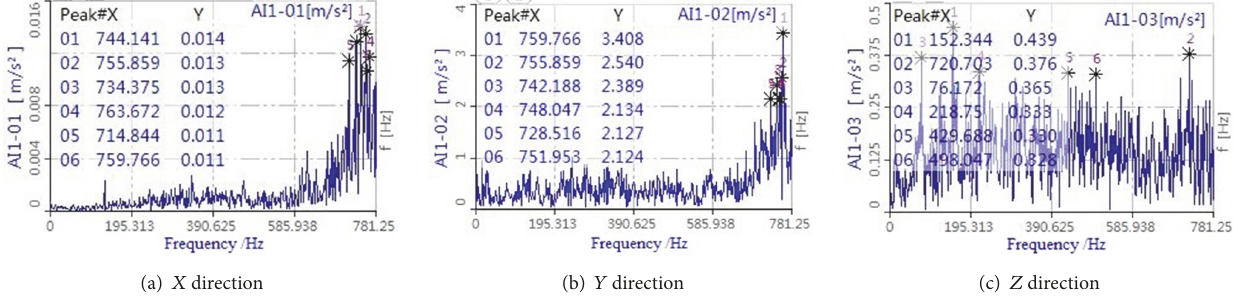
Figure 13: Frequency domain vibration signal of rice threshing